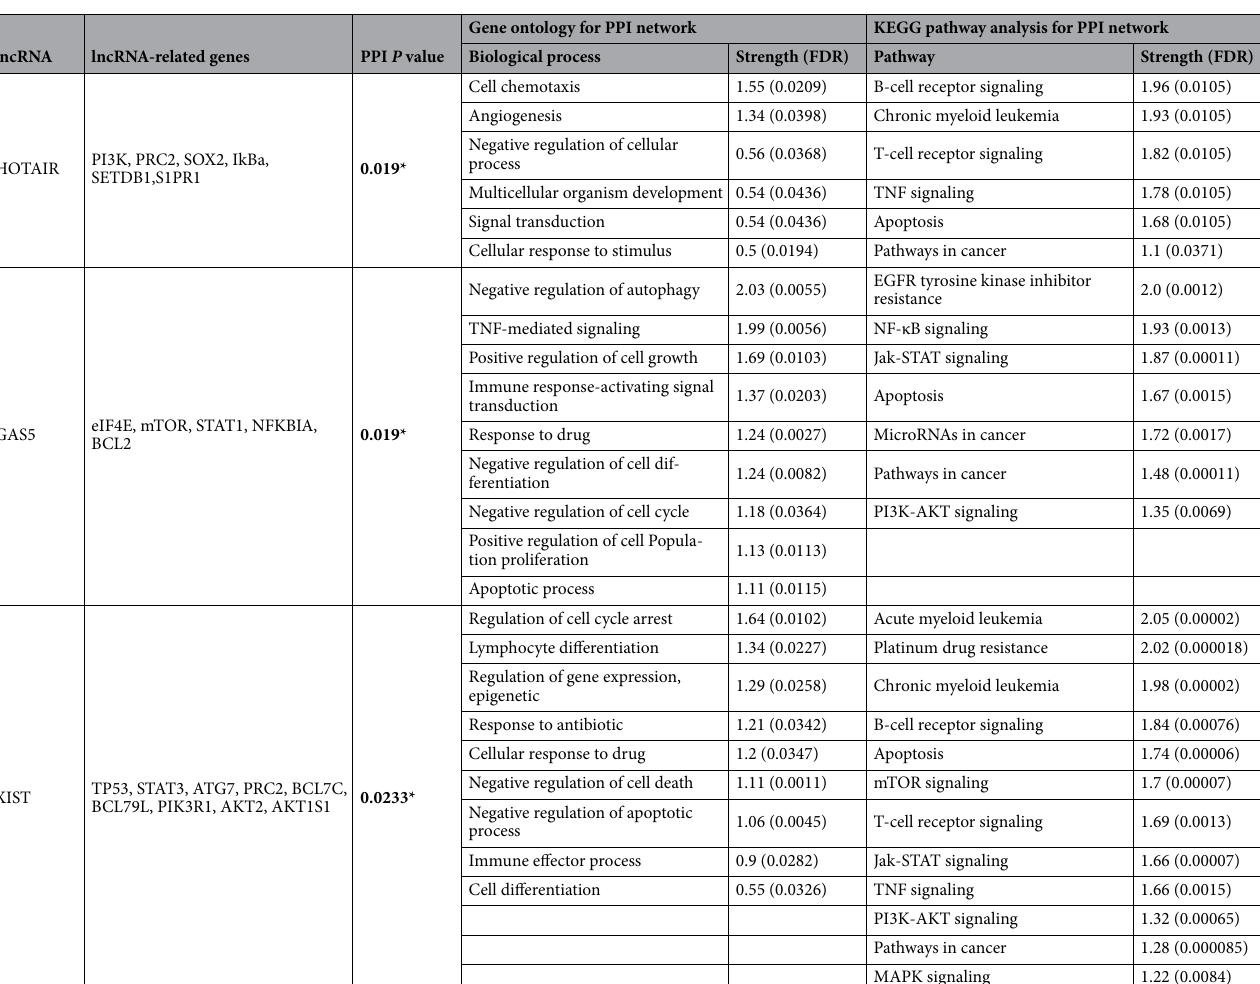
Table 4. Bioinformatics analysis of the lncRNAs-related genes and protein–protein interactions linked to drug responsiveness. The PPI and functional enrichment analysis for the PPI were conducted using SPRING software. PPI, protein–protein interactions; FDR, false discovery rate. *Indicates statistical significance ( P <